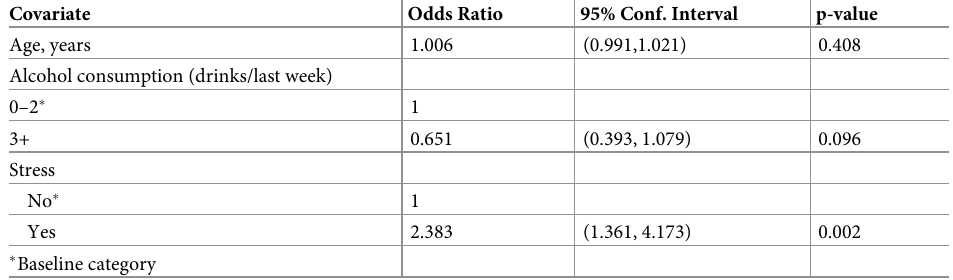
Table 4. Results from weighted logistic regression analysis to assess the factors independently related to thyroid disease in